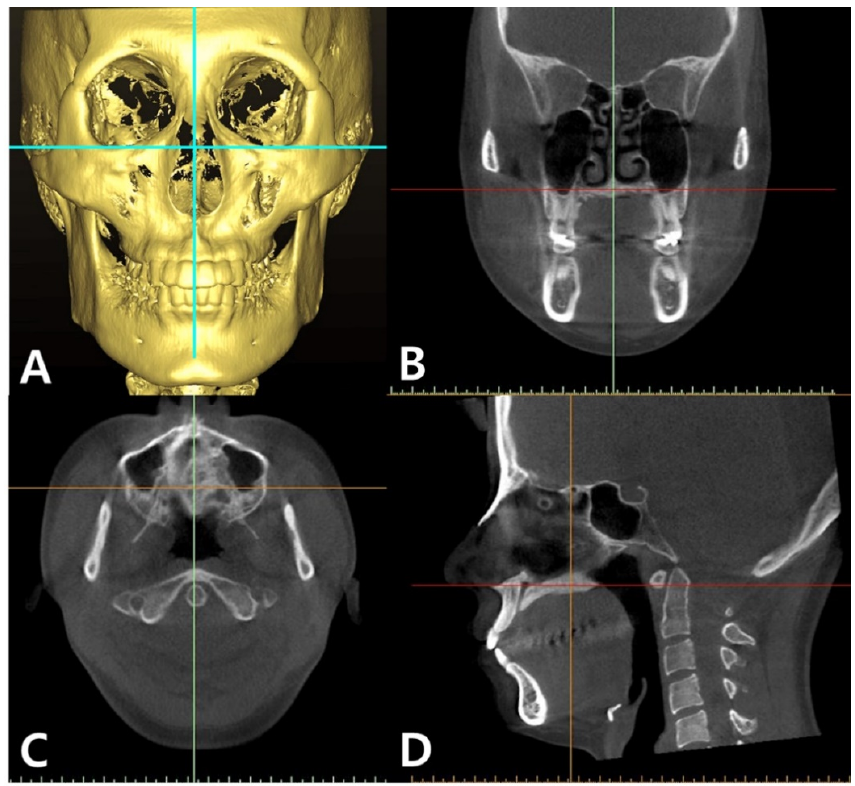
Figure 1. Process of cone-beam computed tomography (CBCT) image reorientation in the multiplanar orientation screen: ( A ) CBCT image was reorientated along the inferior border of the orbital rims in the frontal reconstructed view. ( B , C ) In the coronal and axial views, CBCT images were reoriented to allow for analysis at the midpalatal suture so that the green vertical line was positioned through the anterior nasal spine (ANS) to posterior nasal spine (PNS). ( D ) In the sagittal view, the CBCT image was rotated to confirm that the midpalatal line ran through ANS to PNS.